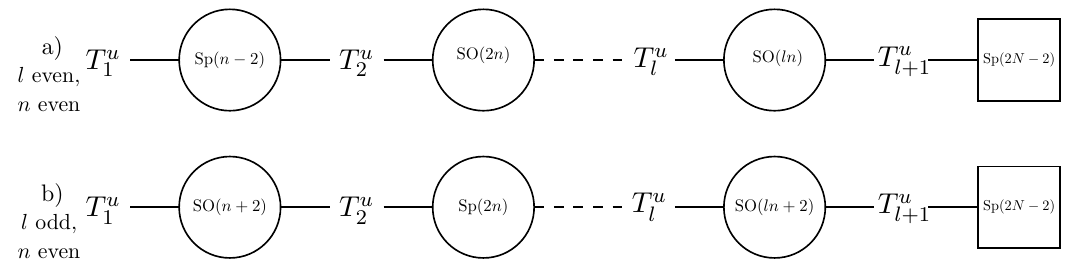
Figure 4 . Quiver for twisted D N type theory defined using formula (6.23). Here we have a) l = 2 N − 1 , b) l = 2 N − 2 − 1 , and u = n + k . n n